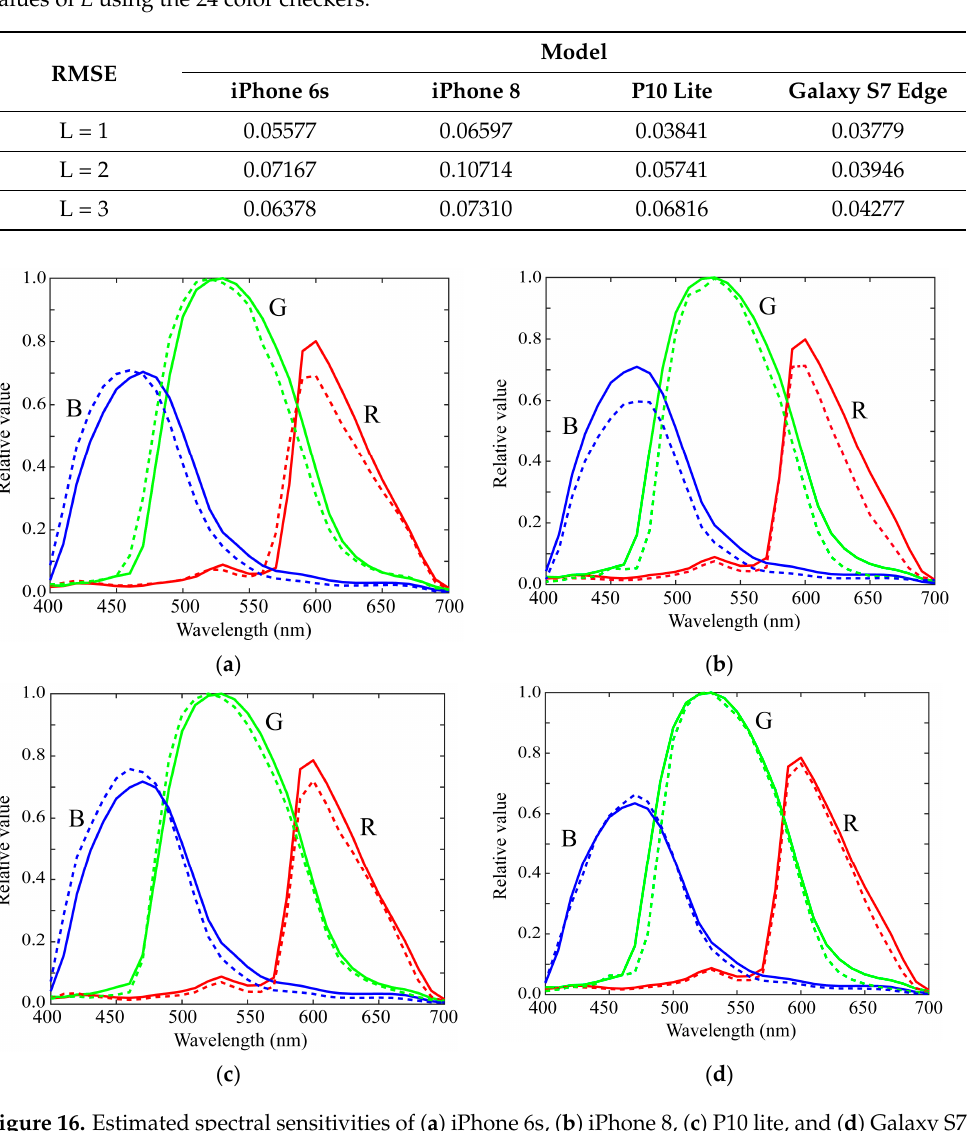
Table 3. RMSE of the estimated spectral sensitivities for four mobile phone cameras at different values of L using the 24 color checkers.